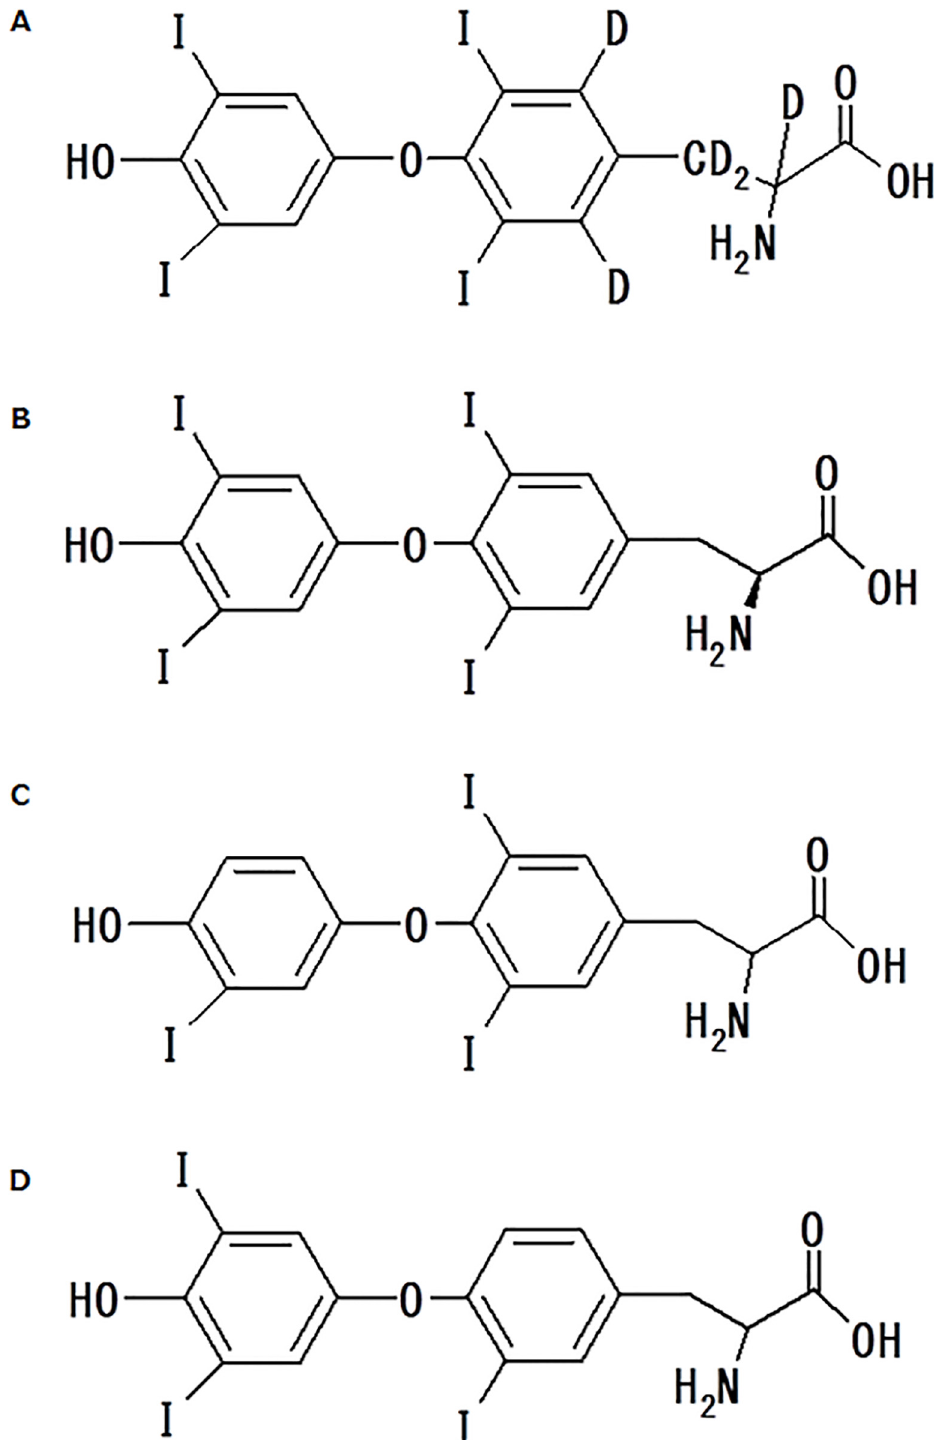
Fig 1. Chemical structures of [ 2 H 5 ]T4 (A), T4 (B), T3 (C), and rT3 (D).